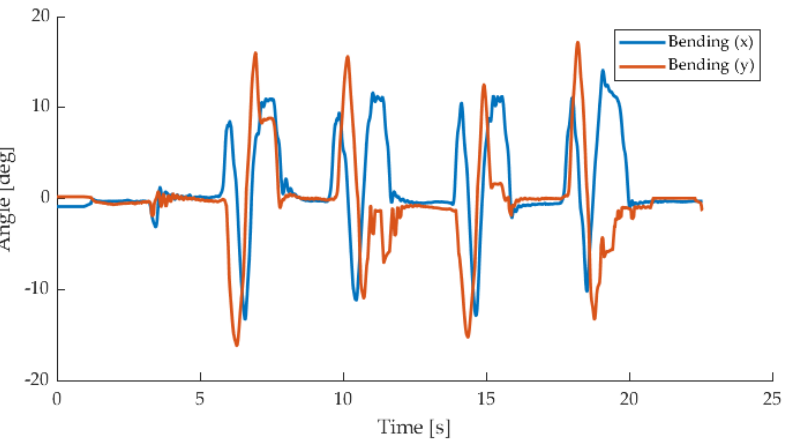
Figure 7. Experimental setup for the validation of the proposed kinematic model, including the torso mechanism, an Arduino microcontroller, a joystick for teleoperation, and a power supply. Figure 8. Raw orientation data acquired by the IMU on the upper torso expressed as bending around the x - and y -axes of the upper torso of the robot in Figure 6.